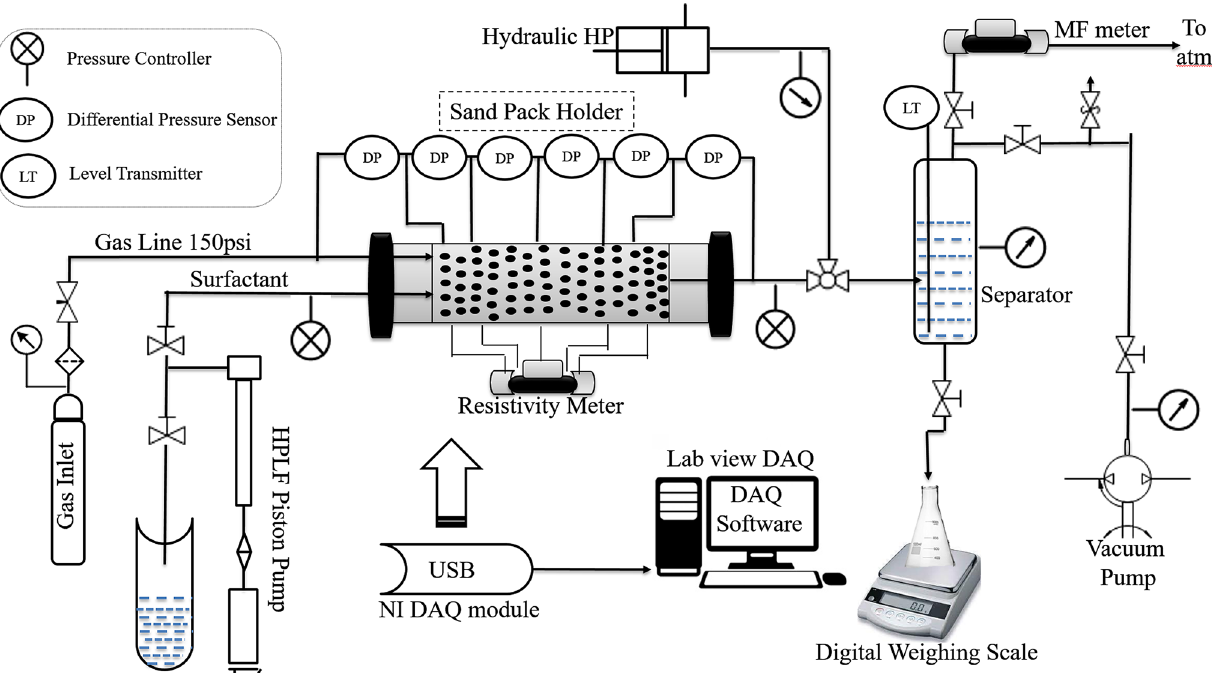
Fig. 2 Sandpack foam flooding